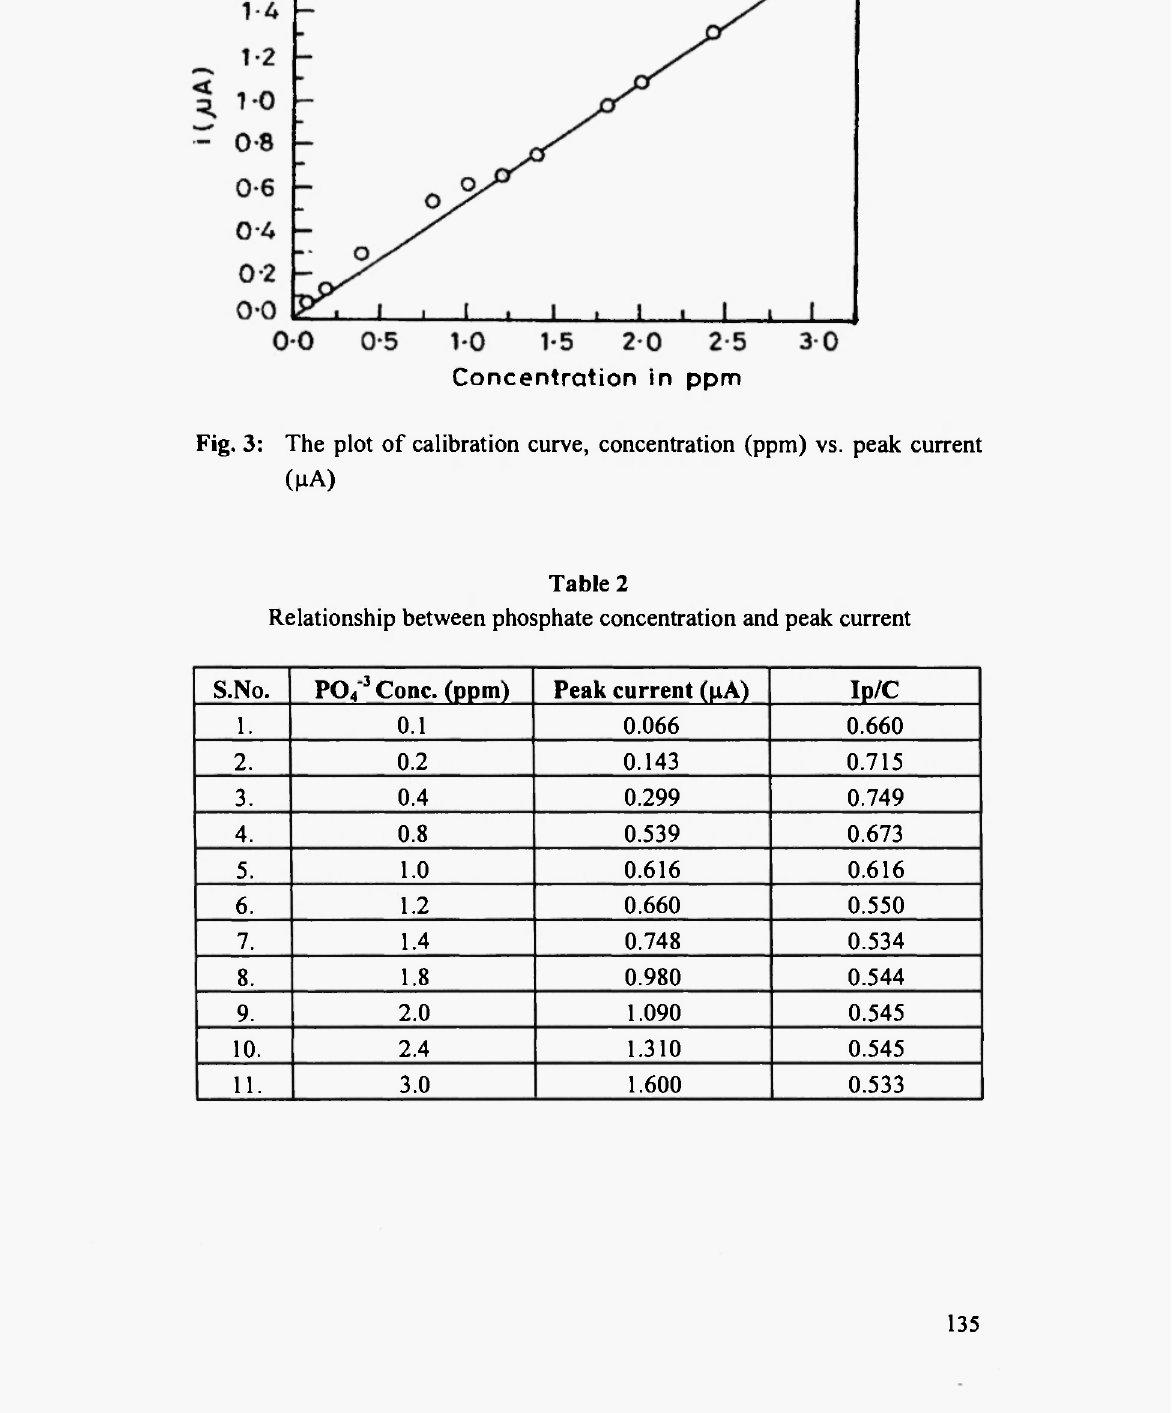
Concentration in ppm Fig. 3: The plot of calibration curve, concentration (ppm) vs. peak current (μΑ)